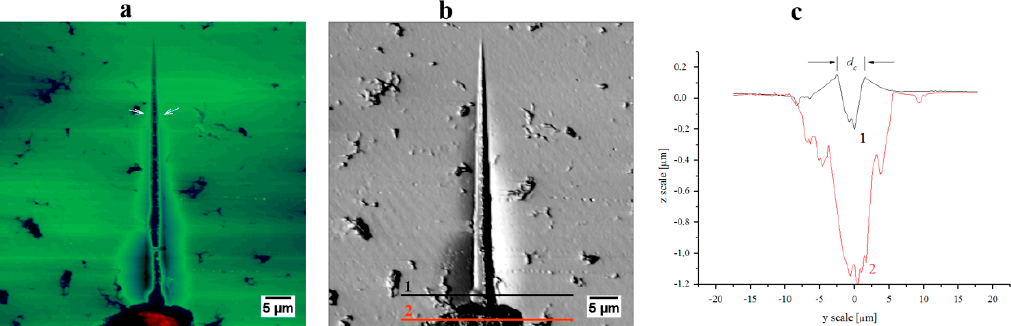
Figure 9. AFM images of the first nm of a high-load nanoscratch. ( a ) Height channel and ( b ) phase channel. Onset of lateral cracking in the film is pointed in figure ( a ) with arrows. ( c ) Profile of sample surface right before (1) and after (2) film delamination and chipping. Pore-like features on the top surface of the samples correspond to the irregularities of the mullite coatings after polishing.